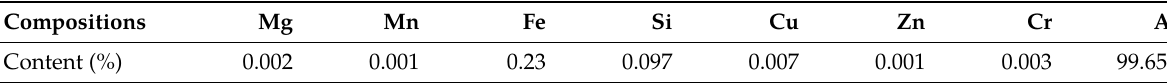
Table 1: Chemical composition of 19501 aluminium alloy (wt%).